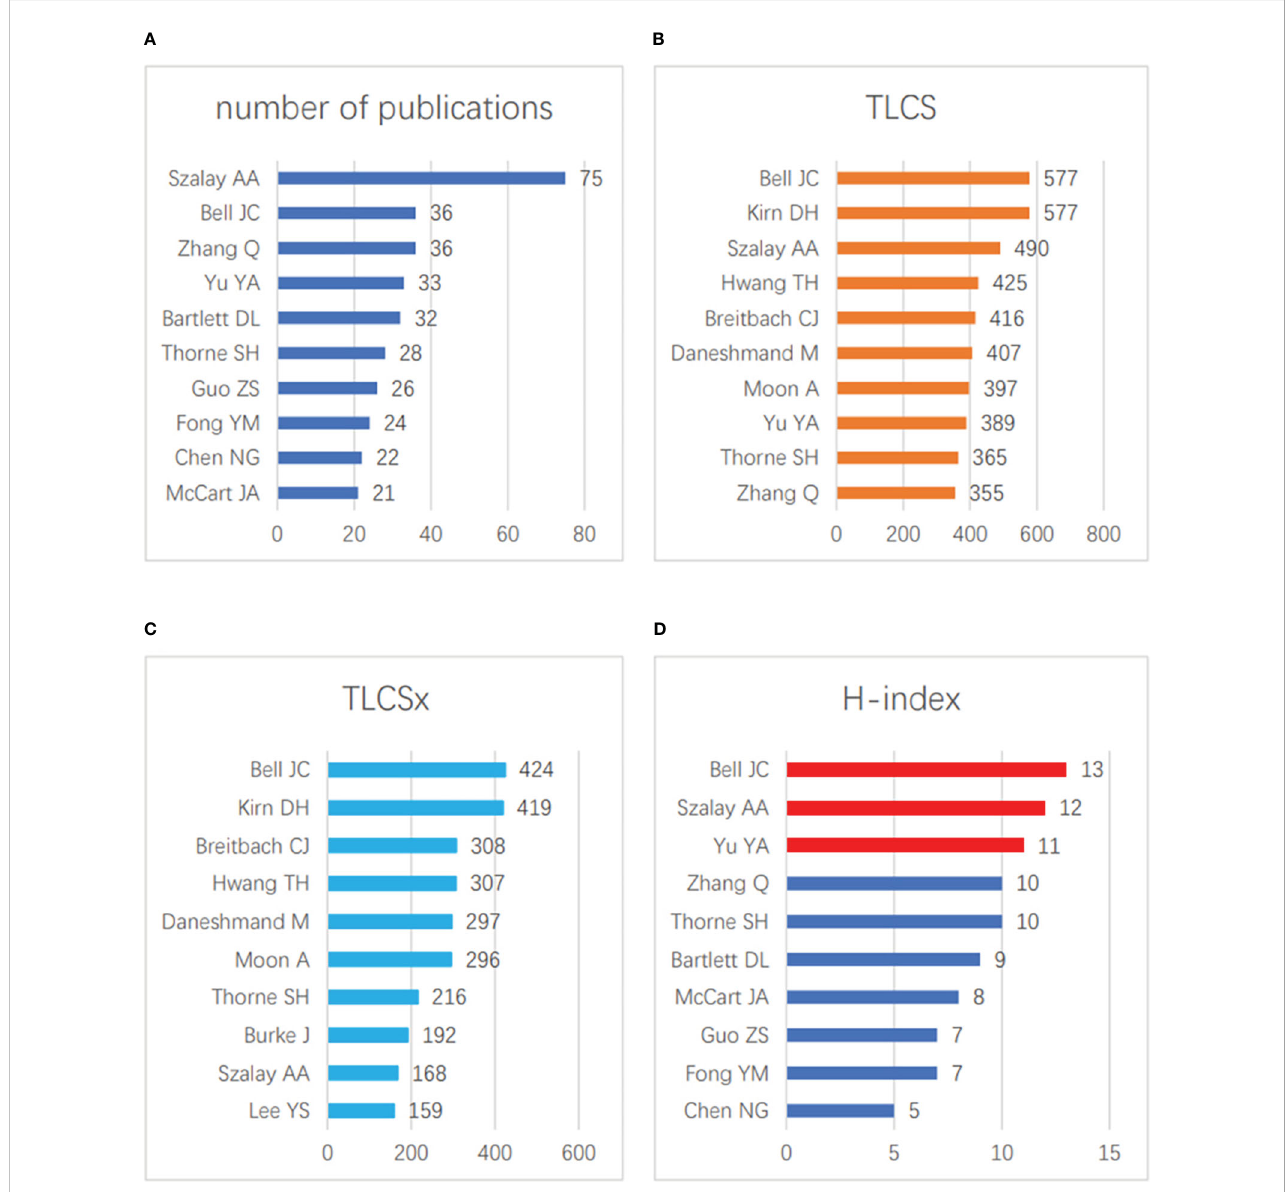
FIGURE 3 Contributions of scholars. (A) The top 10 scholars in terms of the total number of published articles. (B) The top 10 scholars in terms of the total number of LCS. (C) The top 10 scholars in terms of the total number of LCSx. (D) The top 10 scholars with the greatest H-index